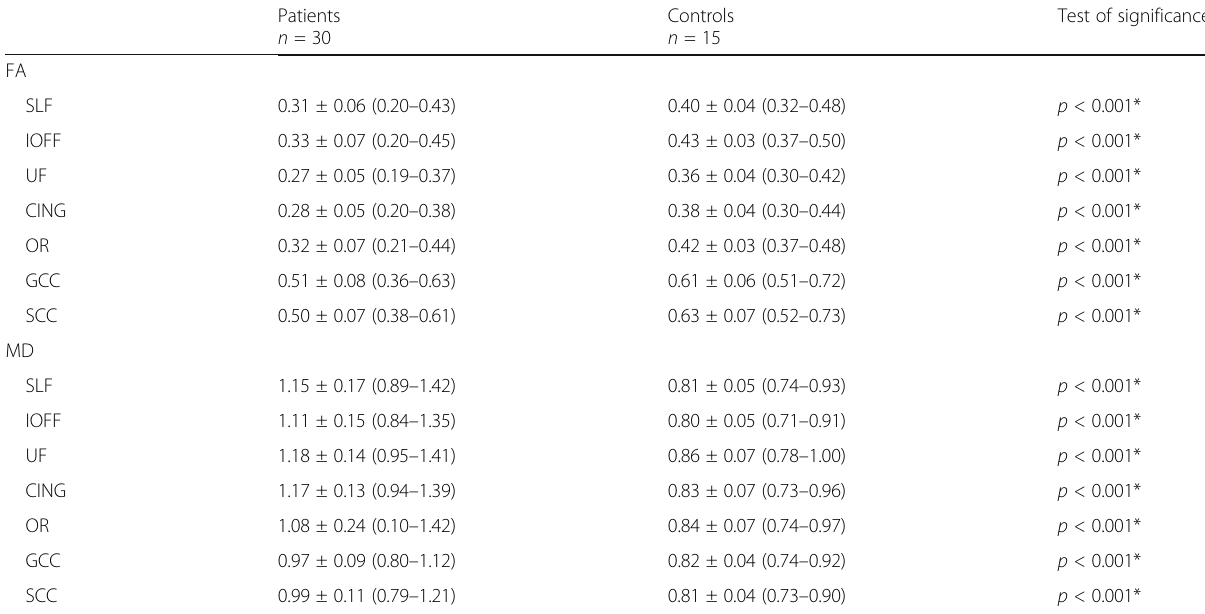
Table 1 The mean and standard deviation (minimum to maximum) of FA and MD (× 10 − 3 mm 2 /s) values of the white matter tracts in patients with severe COPD and the controls